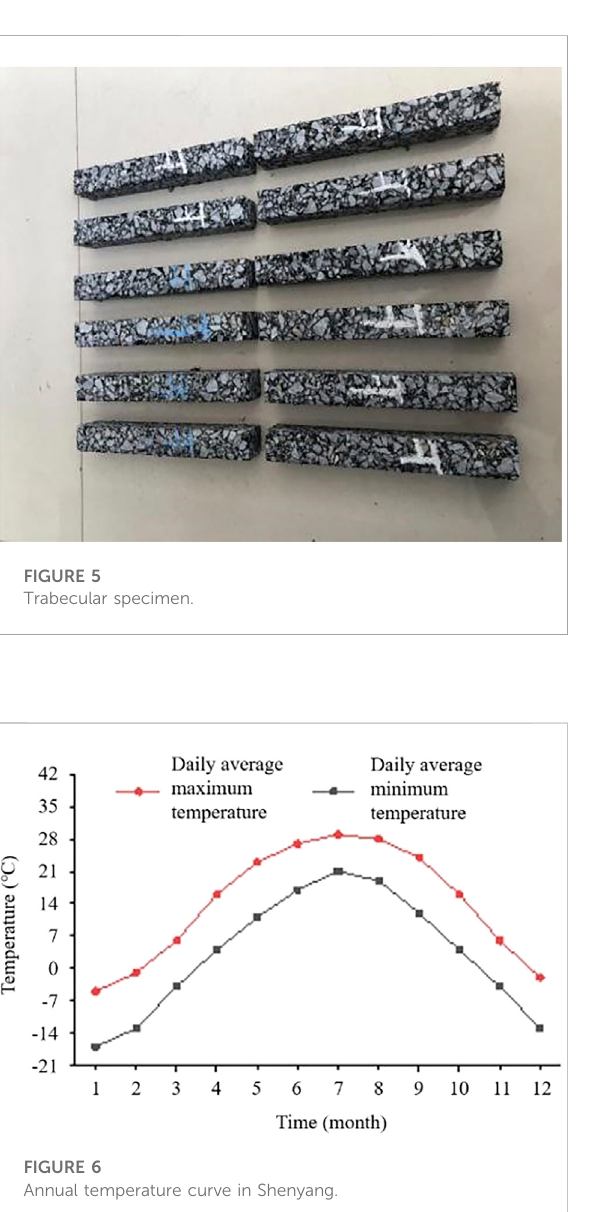
FIGURE 6 Annual temperature curve in Shenyang.